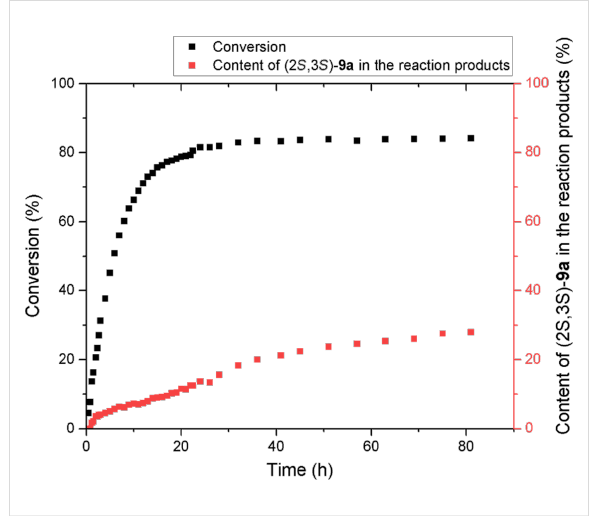
Figure 3: Evolution of the conversion of 5 and diastereomeric compo- sition of the products of reaction of 5a with 6a in the presence of cata- lyst 7a (2 mol %) in chloroform- d